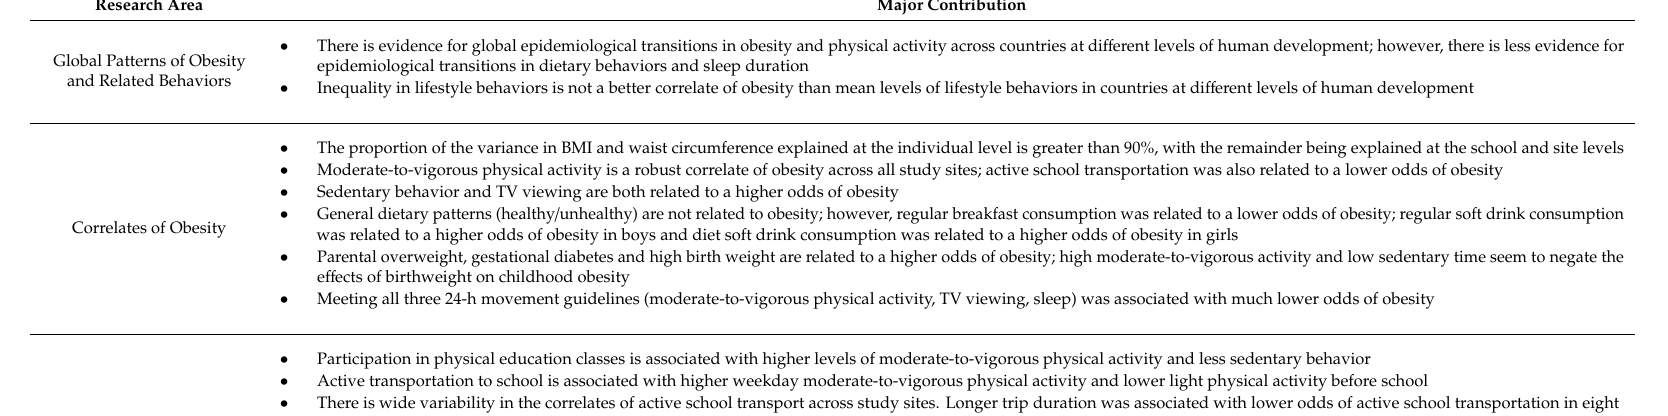
Table 2. MajorresearchcontributionsoftheInternationalStudyofChildhoodObesity, LifestyleandtheEnvironment(ISCOLE)tounderstandingtheglobalobesityepidemic. Research